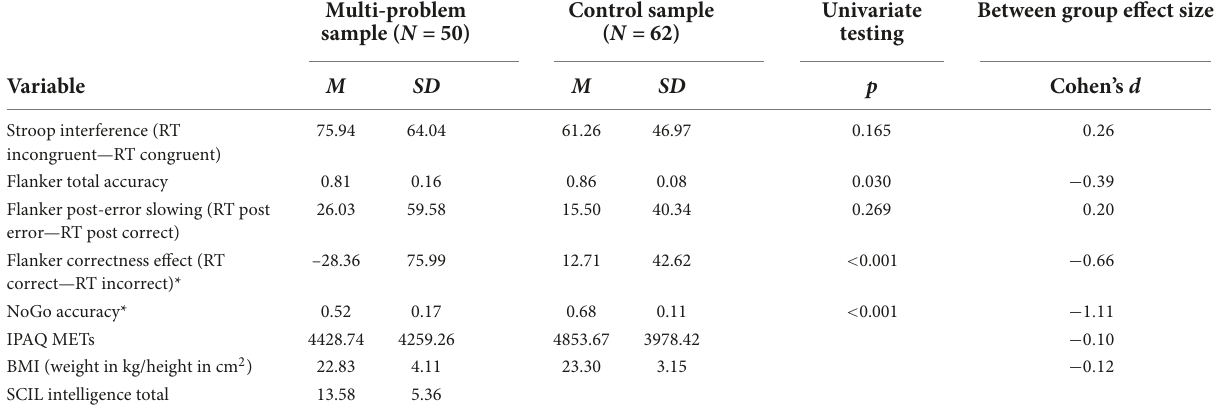
TABLE 1 Main outcome measures of multi-problem young adults and healthy young adults from the general